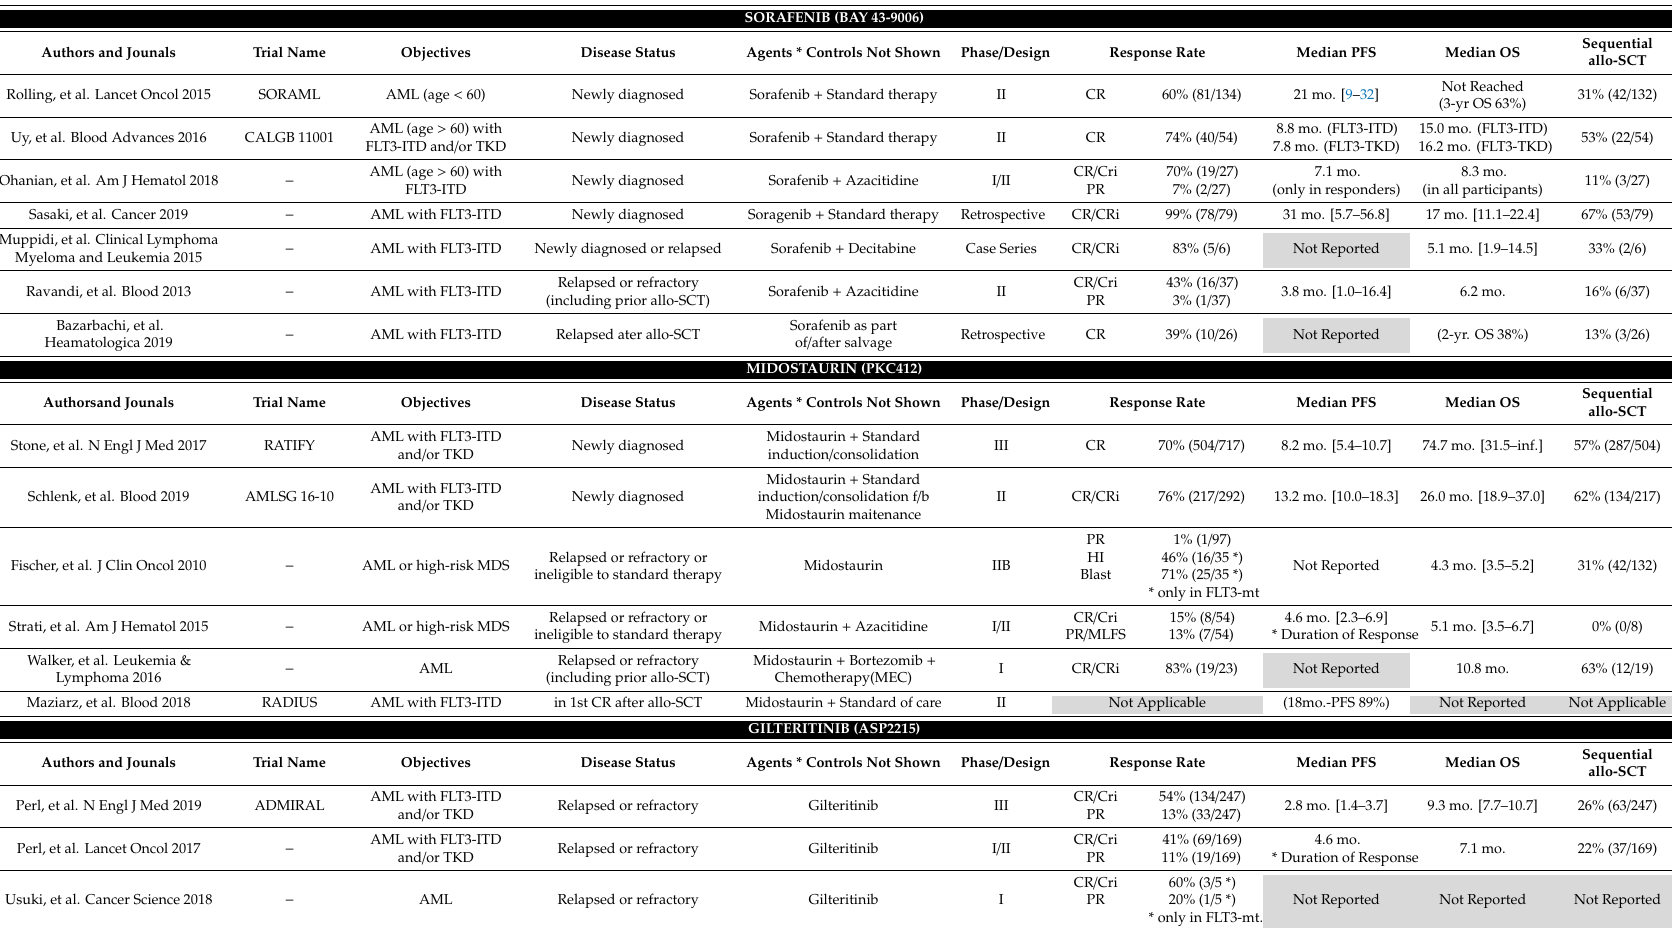
Table 2. Clinical results of FLT3